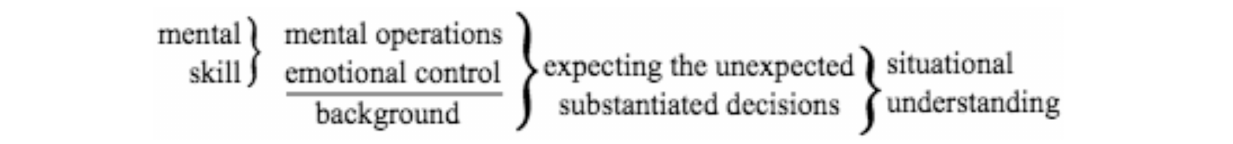
FIGURE 3 | Situational Understanding is a product of background (knowledge, training) and mental skills. A solid horizontal line underscores that skills operate on top of the